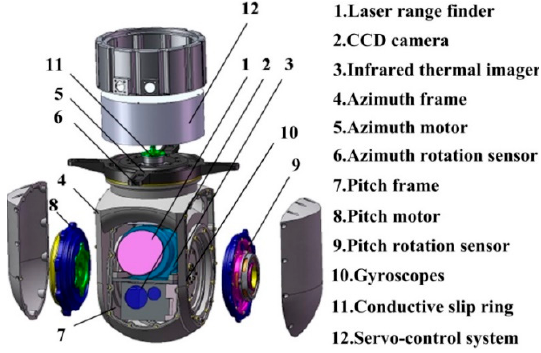
Figure 2. Typical composite of the system.